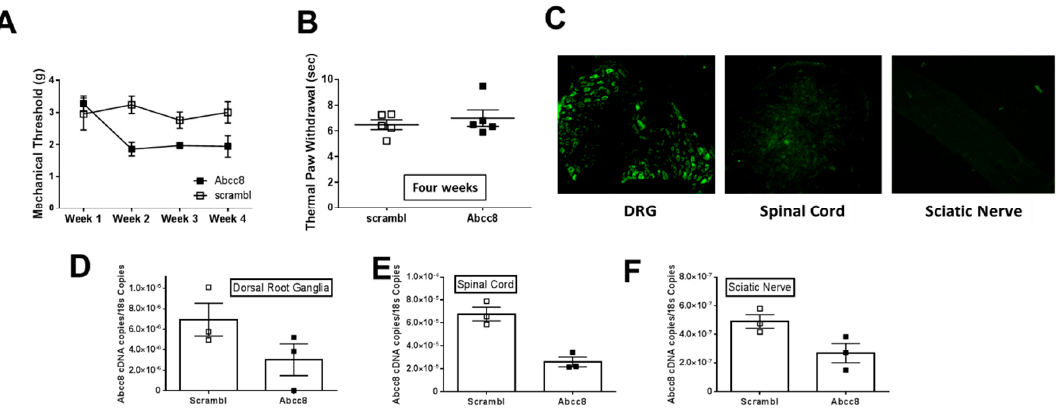
Figure 9. Intrathecal injection of Abcc8 shRNA decreases mechanical paw withdrawal latencies in mice. ( A ) Intrathecal injection of AAV9-GFP-U6-m-ABCC8-shRNA (10 μ L) significantly decreases mechanical paw withdrawal thresholds over time in mice compared to control injections (AAV9-GFP- U6-m-scramble-shRNA) (repeated measures ANOVA, F (3, 24) = 3.02, P = 0.049). ( B ) Thermal paw withdrawals were not significantly changed four weeks post injection. ( C ) Histological images of dorsal root ganglia (DRG), spinal cord and sciatic nerve section from an animal after Abcc8 shRNA injection. Green fluorescent protein is detected in both primary afferent cell bodies and in the spinal